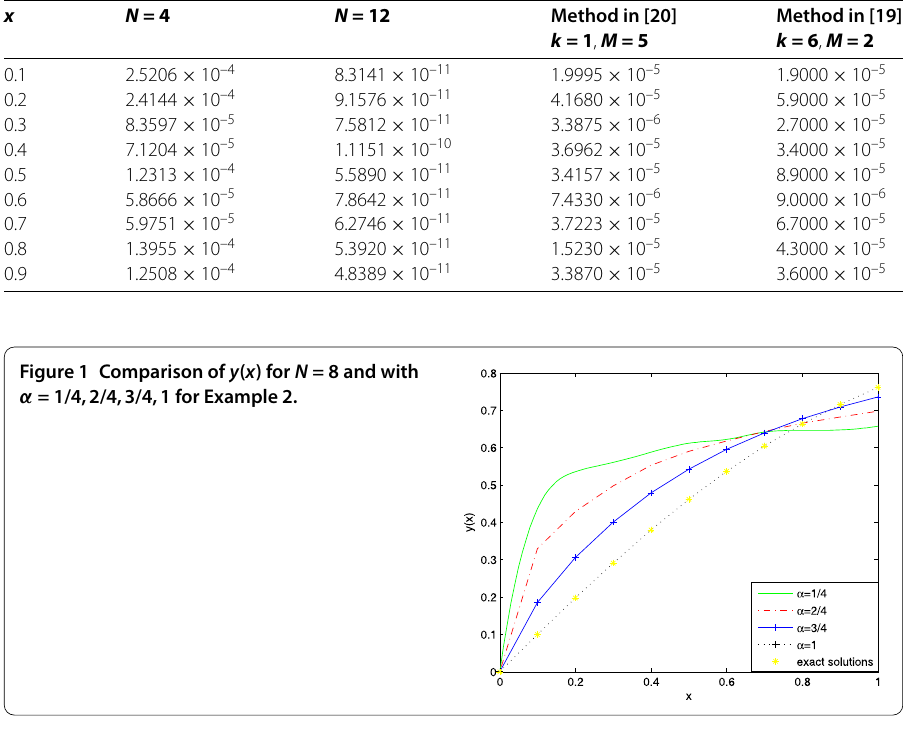
Table 4 Absolute errors for α = 1 using N = 4,12 for Example 2